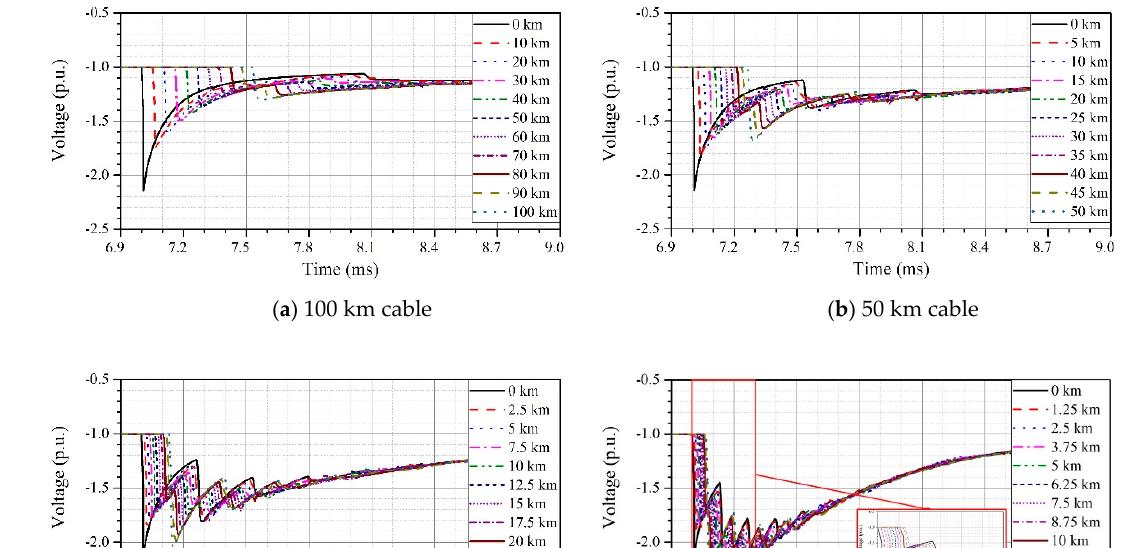
Figure 9. Core-ground overvoltage at the entrance of a cable according to the length of the cable.